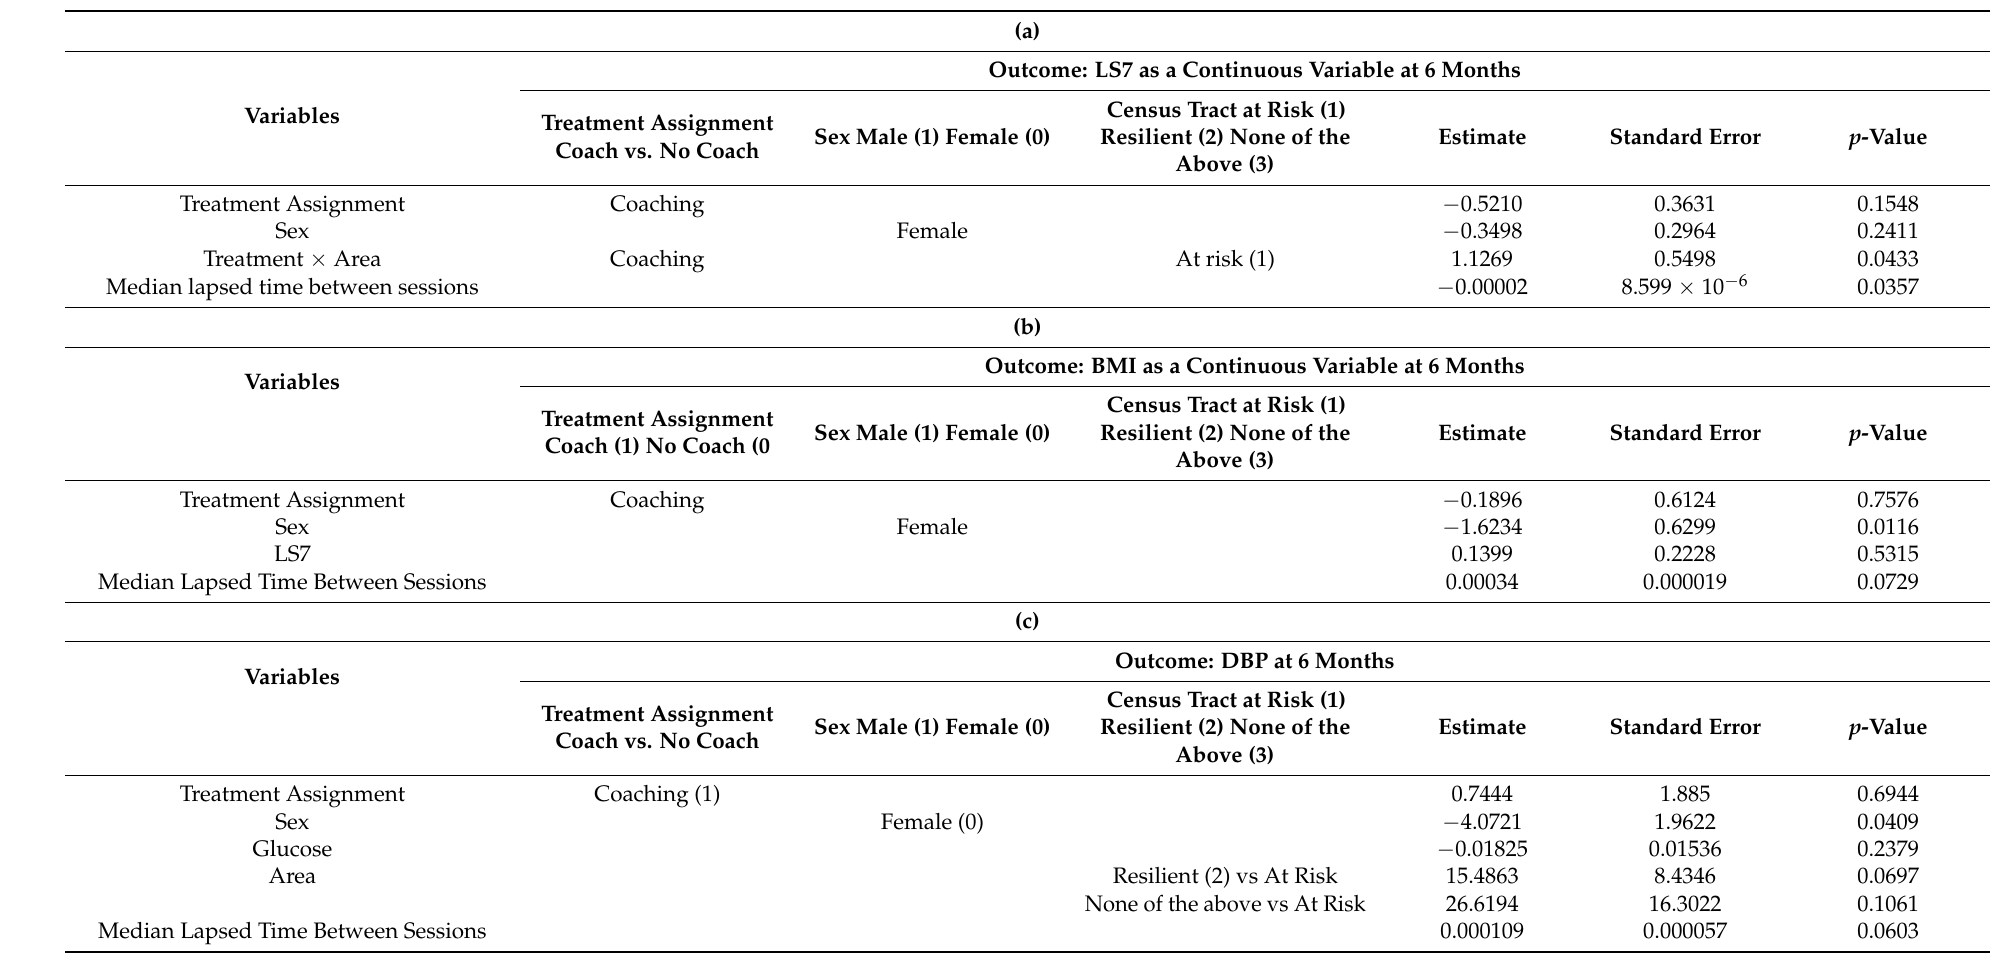
Table 3. Generalized Linear Mixed Models (GLMM) multivariate adjusted analyses of continuous